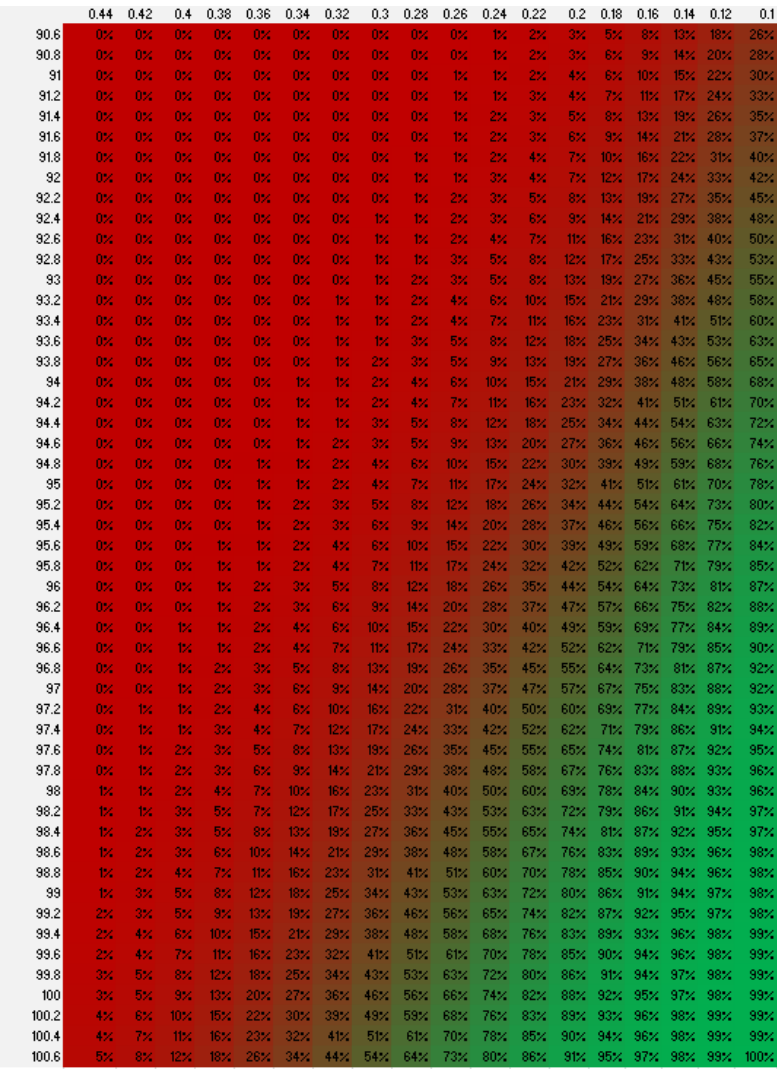
Figure 4. For 2014q1, the projected probability of GDP being in boom state ( d various values of industrial production (82–99) and realized volatility of ASE stock index